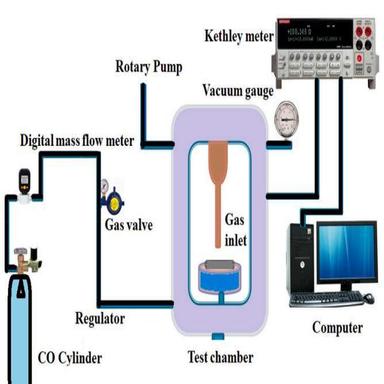
The schematic representation of the C.O. sensing setup.